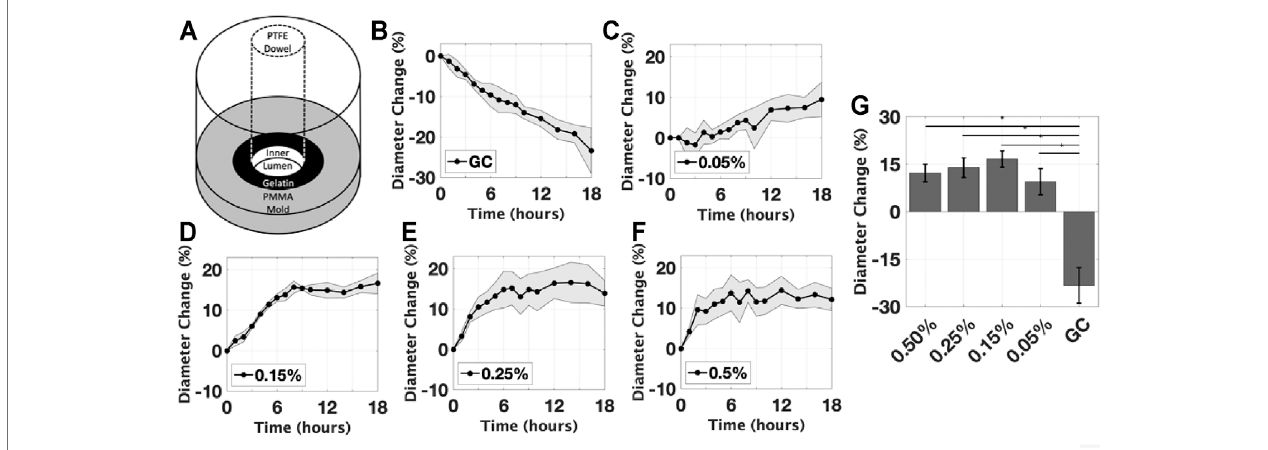
FIGURE4| InitialGelatinExperiments. (A) Aschematicofthemoldwithdowelusedtogelatetheprototype;Theeffectofglutaraldehydeconcentrationonthemean inner diameter expansion, for concentrations of (B) control group without glutaraldehyde, (C) 0.05%, (D) 0.15%, (E) 0.25%, (F) 0.5%. (G) The diameter change measured at the fi nal timepoint of each group is compared, all groups were found to be signi fi cantly different than GC (* p < 0.05). Data are reported as mean ± s.d.